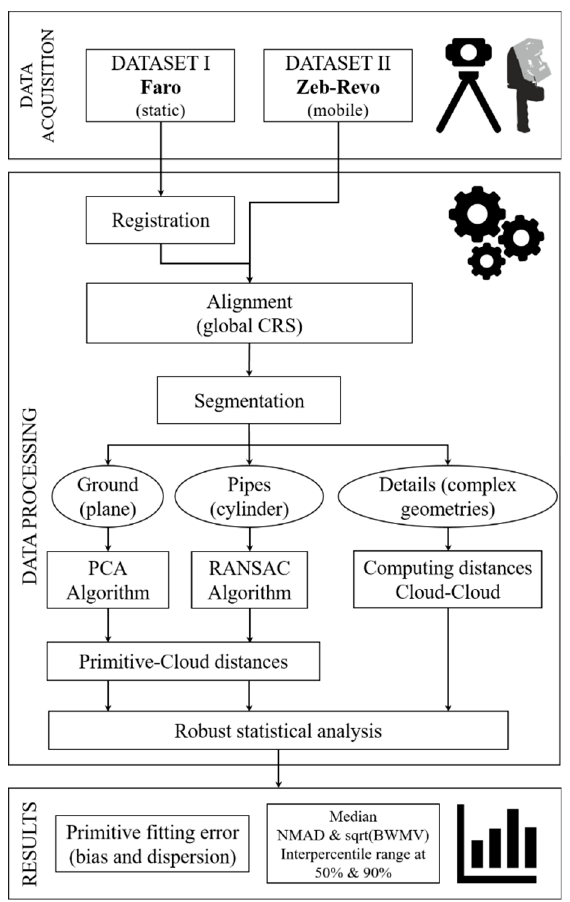
Figure 2. Pipeline for the validation of portable mobile mapping system for inspection tasks in thermal and fluid-mechanical facilities.